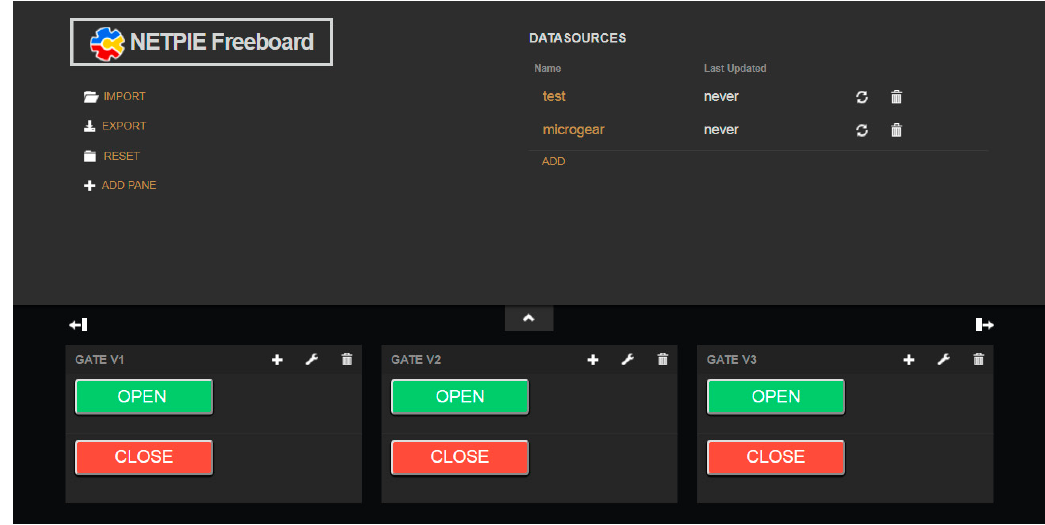
Figure 23. Button function in NETPIE.io.